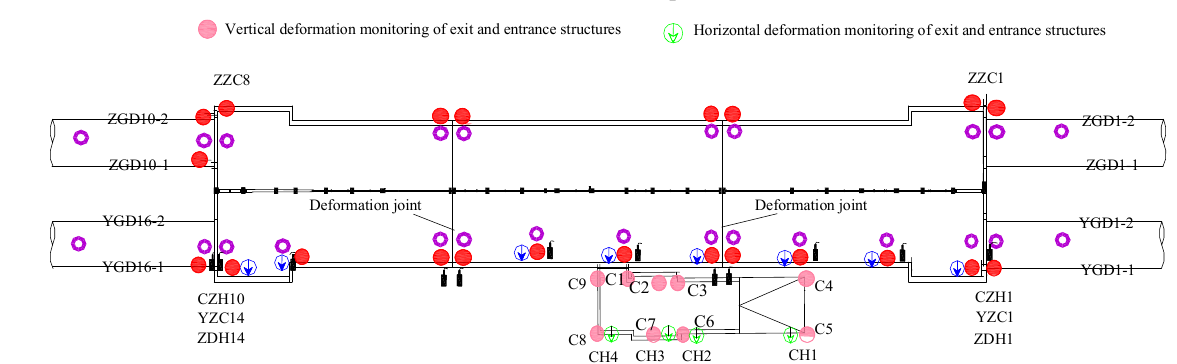
Table 3. The management values of the allowable deviation of the static geometric dimensions of the track.